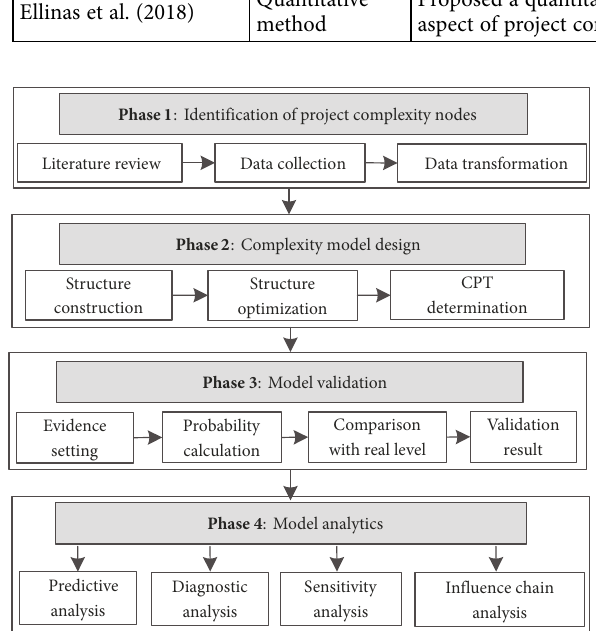
Figure 1. Flowchart for implementing project